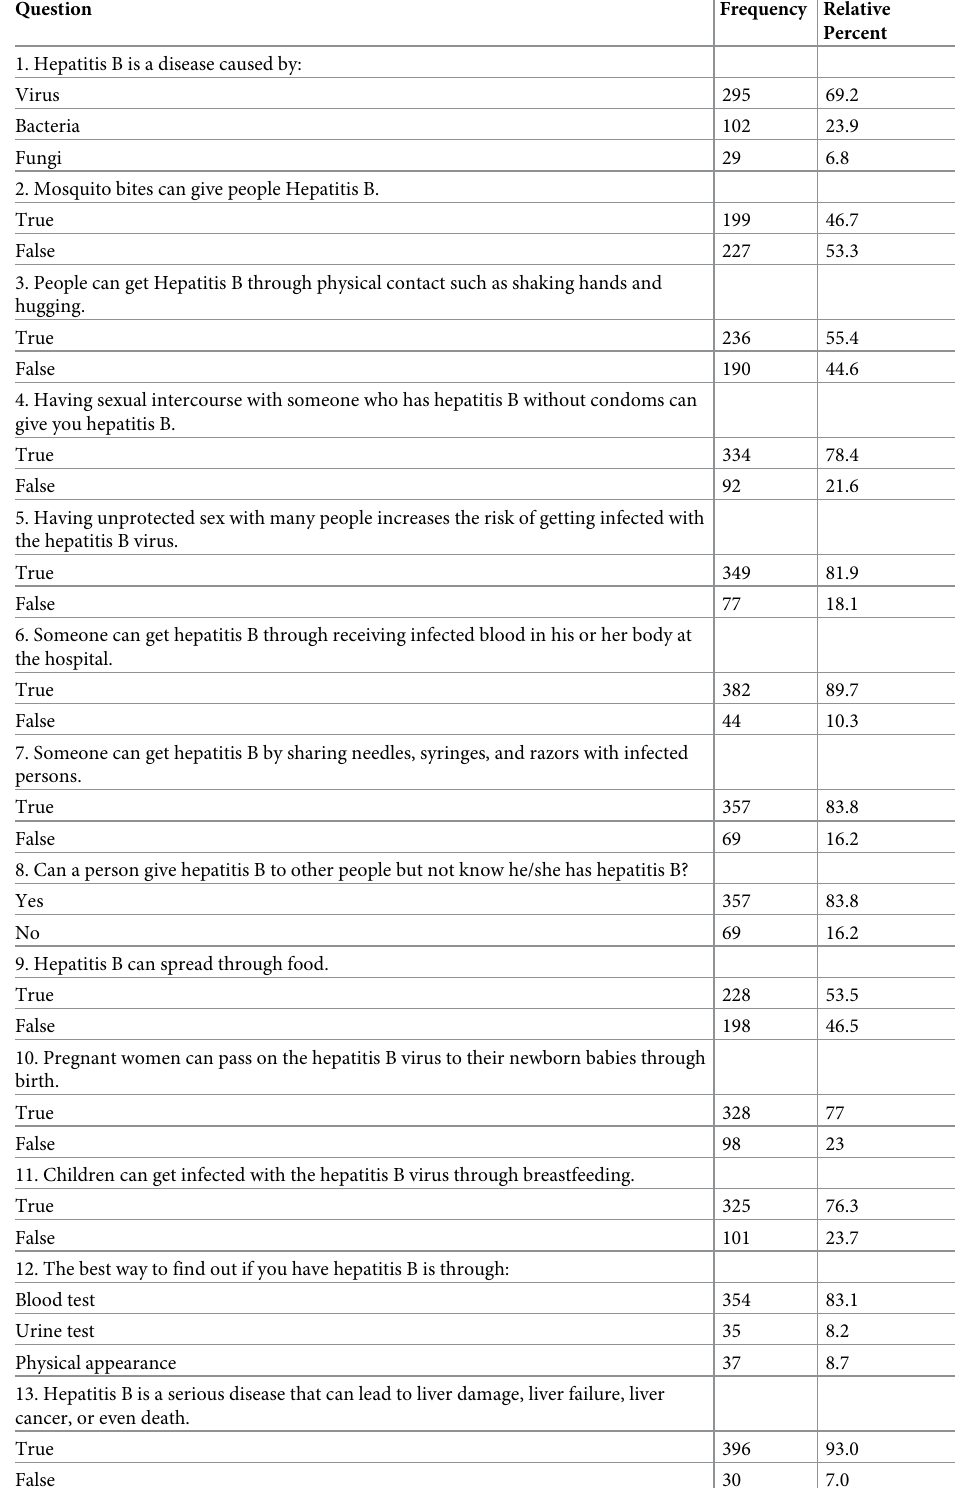
Table 1. Hepatitis B Knowledge questionnaire’s responses in relative